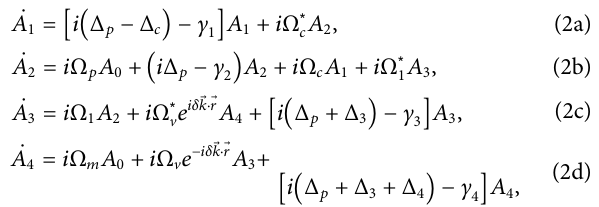
FIGURE 1 | Schematic of a fi ve-level atomic system.